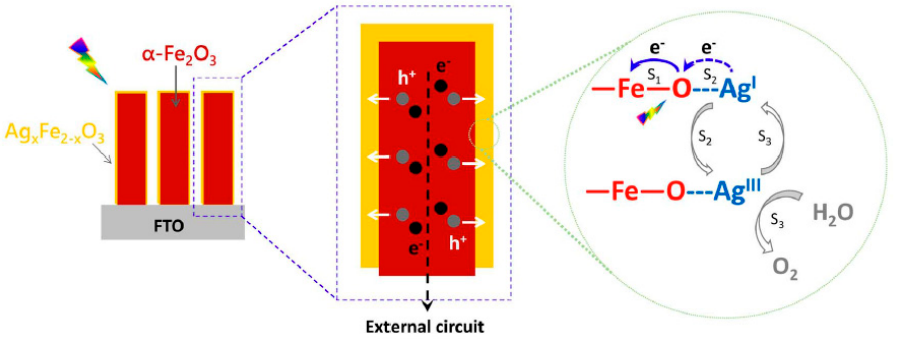
Figure 6. Core/shell structured α -Fe 2 O 3 /Ag x Fe 2-x O 3 nanorods and schematic of water oxidation reaction accelerated by Ag x Fe 2 − x O 3 overlayer. Adapted with permission from [64]. Copyright 2014 Nature Publishing Group.